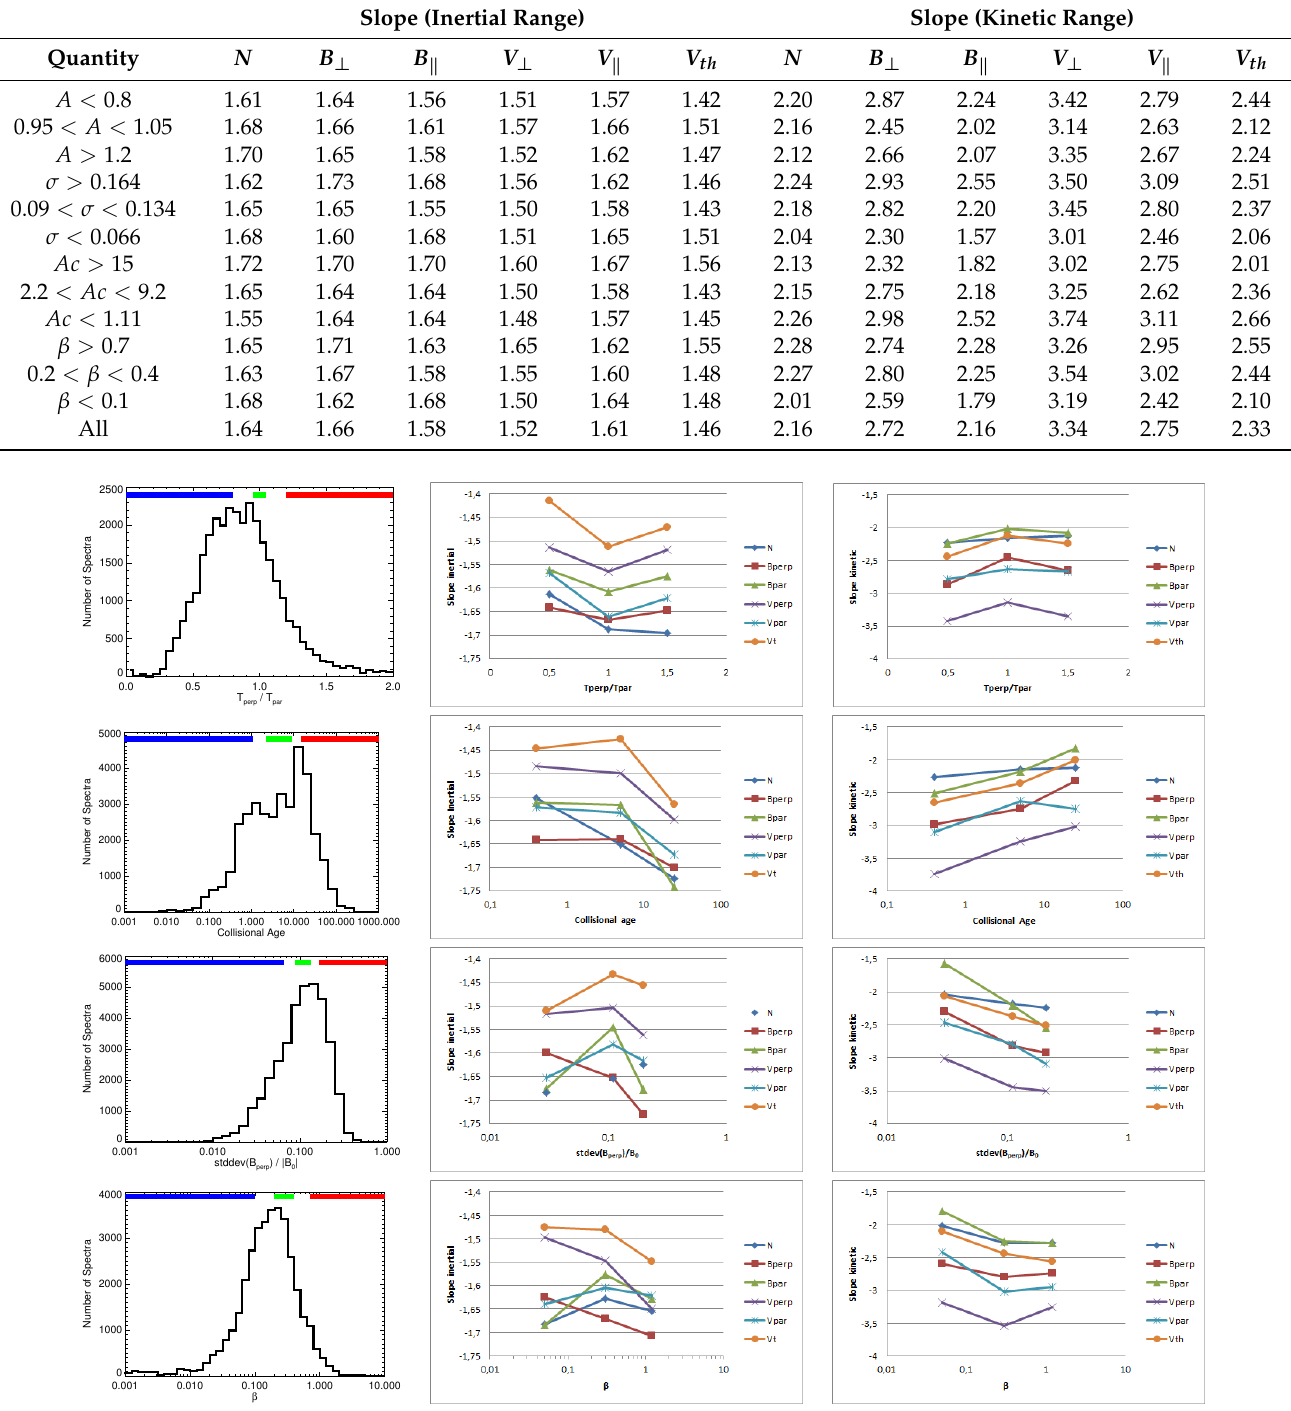
Figure 7. The slopes of fluctuation spectra in inertial (middle panels) and kinetic (right-hand panels) ranges of frequencies as a function of temperature anisotropy (top row), collisional age (second row), level of magnetic field fluctuations (third row) and ion beta (last row). The distributions of particular parameters in the analyzed set are in the first column, the ranges used for averaging are indicated by color bars in each histogram and are also introduced in Table 1. Color and symbol codings in all panels of spectral slopes are: N —blue (cid:5) ; B ⊥ —red (cid:3) ; B (cid:107) —light green (cid:52) ; V ⊥ —violet × ; V (cid:107) —light blue (cid:63) ; and V th —orange •